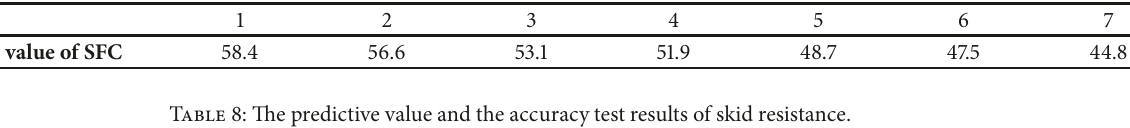
Table 7: The monitoring value of average SFC for prediction.